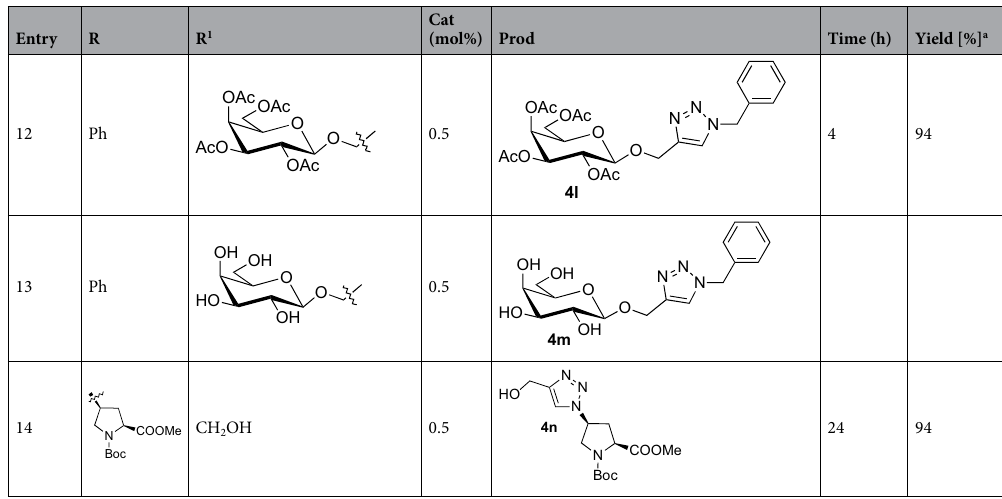
Table 2. Scope of the 1,3-dipolar cycloaddition reaction catalyzed by Cu-AmP-CPG 1.